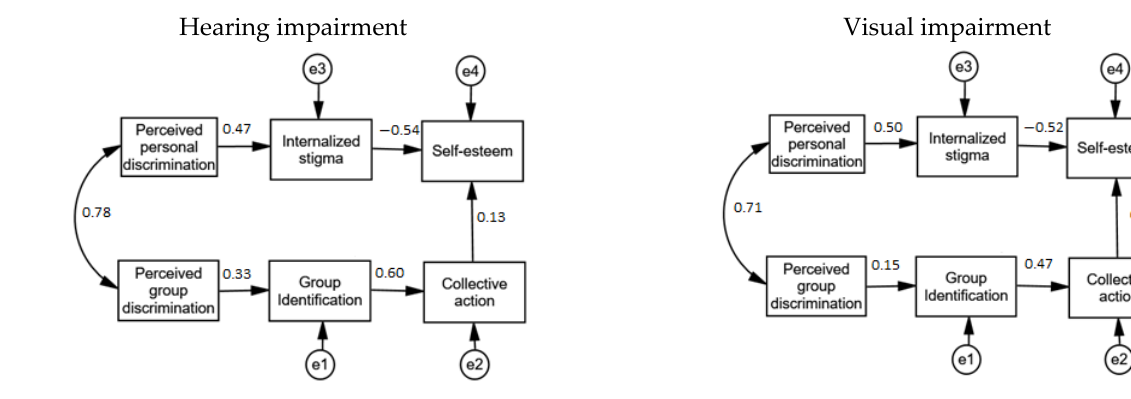
Table 3. Results of mediation